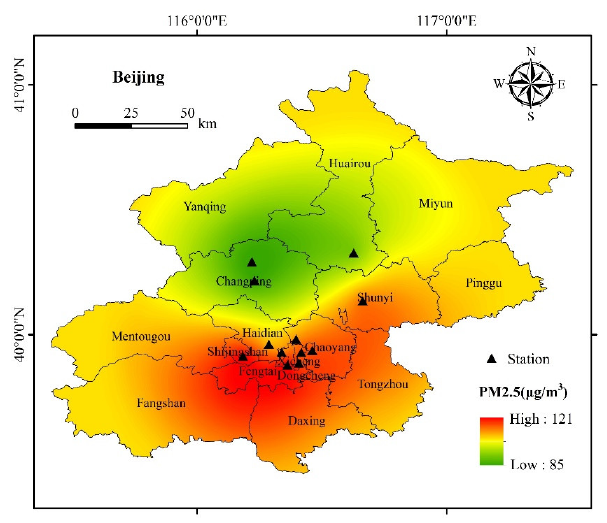
Figure 5. Spatiotemporal distribution features of PM 2.5 concentration.